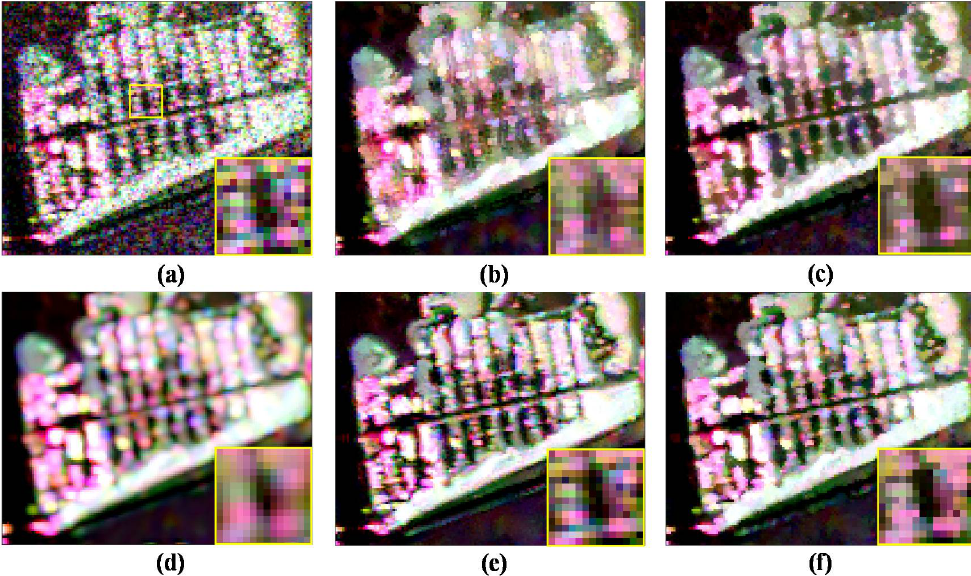
Figure 11. Enlarged details on marked region 5. ( a ) Original data. ( b ) Refined Lee filter. ( c ) IDAN filter. ( d ) Pretest filter. ( e ) NL-SAR filter. ( f ) The proposed ANLM